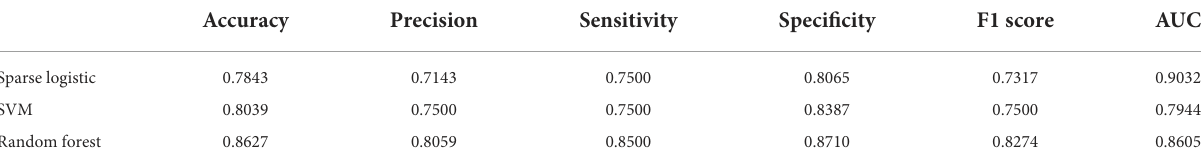
TABLE 3 Performance of machine learning algorithms.